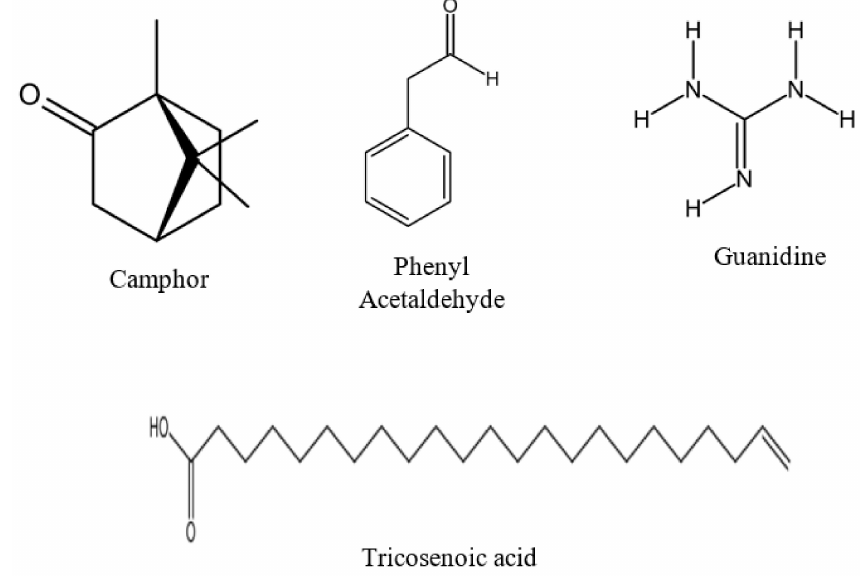
Figure 10. Major constituents in RSF EtOAc